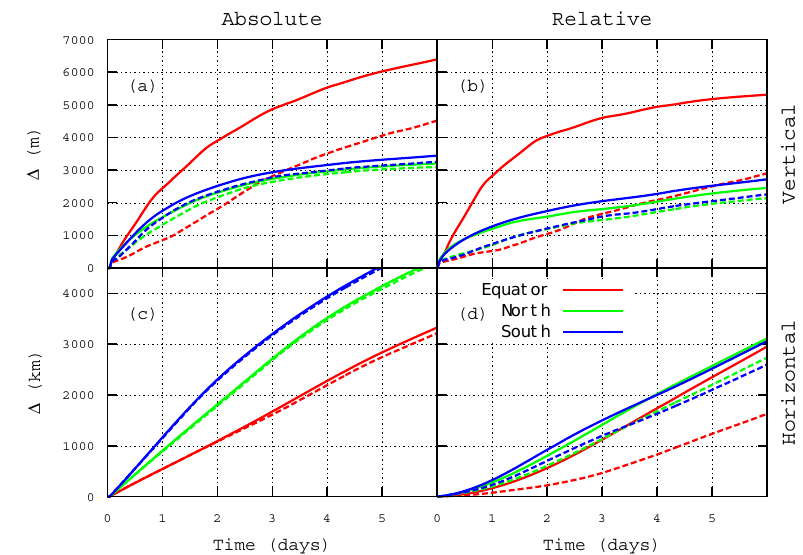
Figure 4. Vertical absolute dispersion (a) , vertical relative dispersion (b) , horizontal absolute dispersion (c) , horizontal relative dispersion (d) . Notice that panels (b) and (d) share the same y axis with panels (a) and (c) , respectively. Continuous lines refer to experiments with the MC convection scheme active, while the dashed lines mark experiments made without it. Line colours indicate the tropical distribution (red), northern middle-latitude distribution (green), southern middle-latitude (blue), respectively. Absolute and relative dispersion are defined by Eqs. (18) and (19).